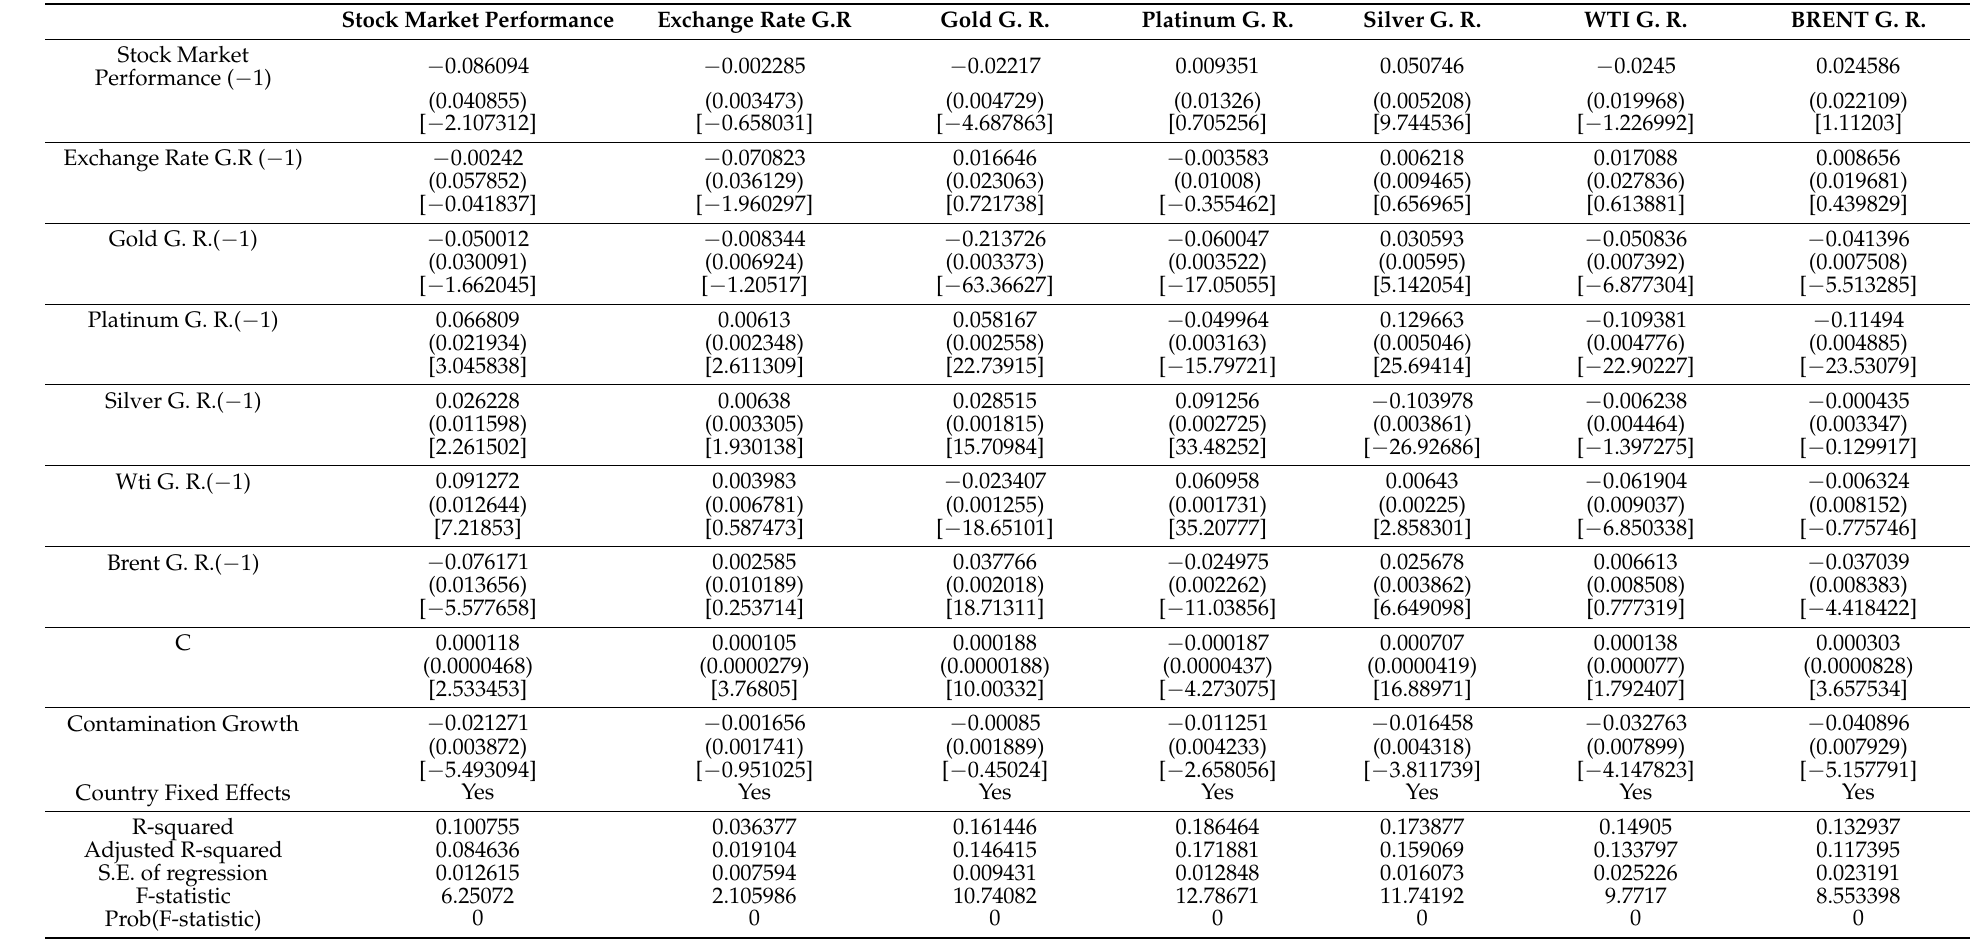
Table A6. Panel Regression with White–Arellano Period Estimator using Cross Section